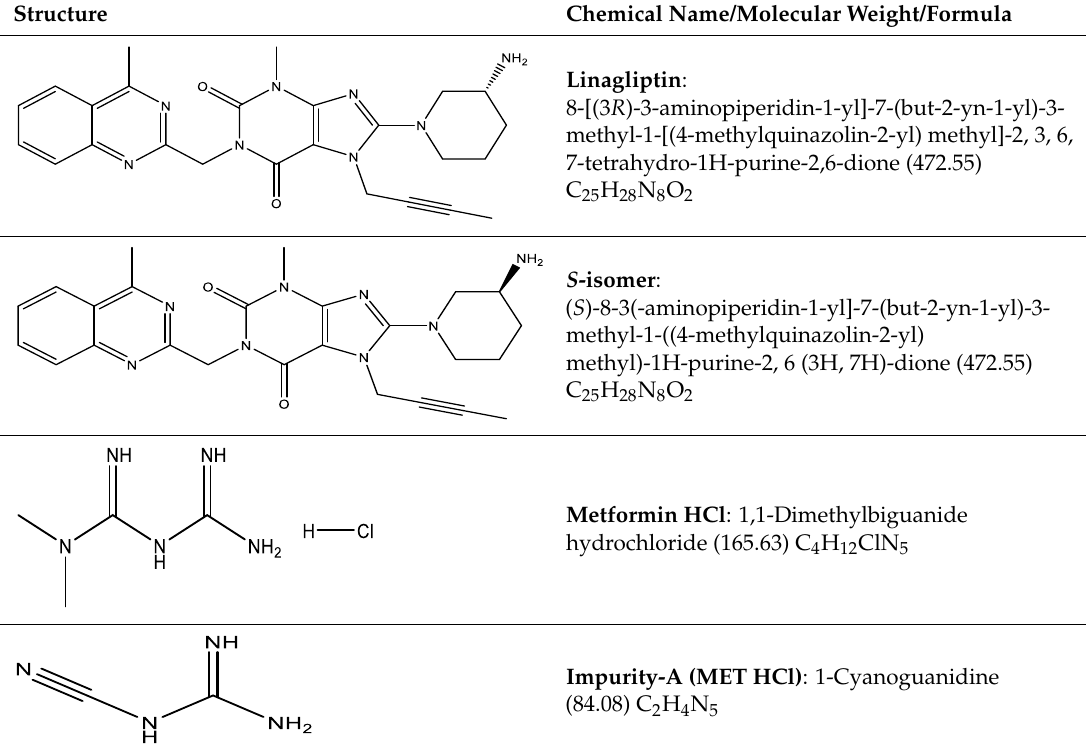
Table 1. Chemical structures of linagliptin (LGP) as well as metformin hydrochloride (MET HCl) and their impurities.